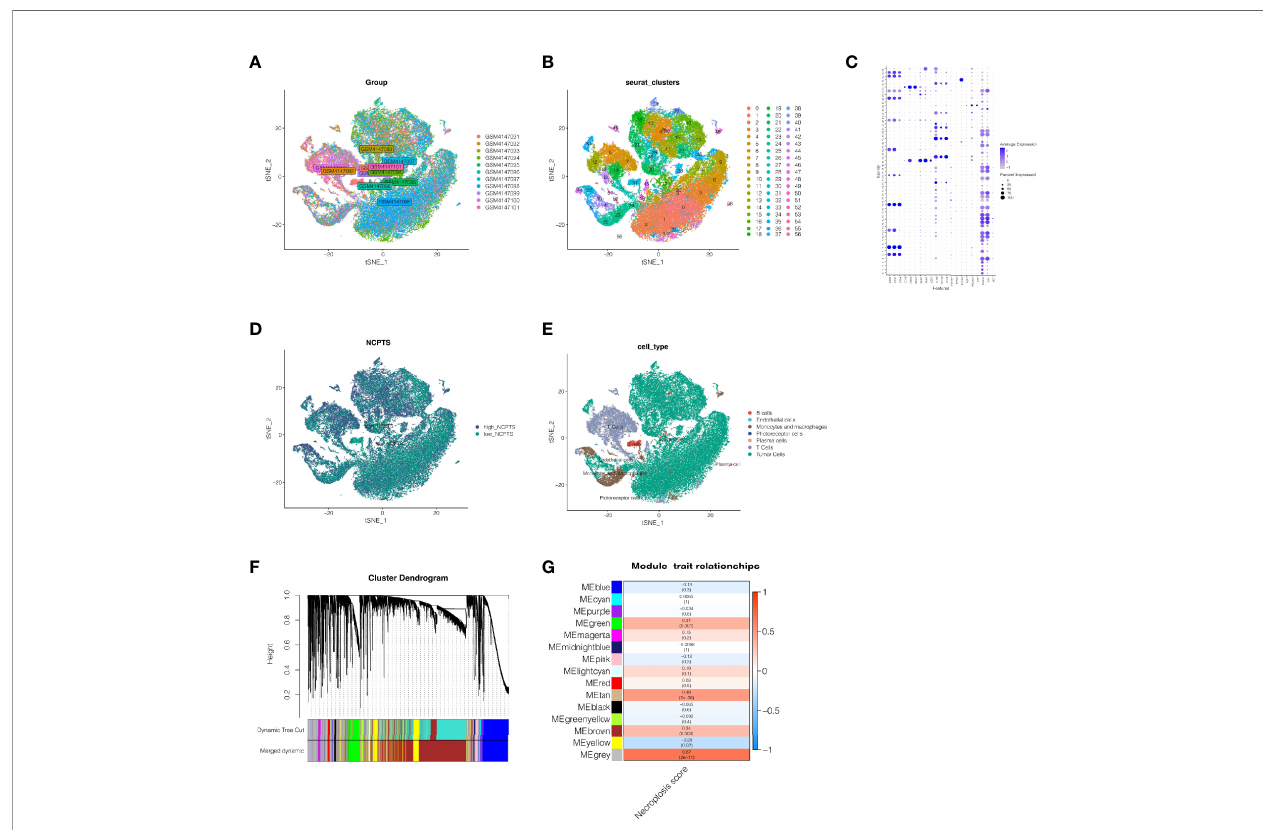
FIGURE 2 | Single cell sequencing analysis of GSE139829. (A) The integration effect of 11 samples is good. (B, C) Dimensionality reduction and cluster analysis. All cells in 11 samples were clustered into 57 clusters. (D) The percentage of necroptosis genes in each cell. The cells were divided into high- and low-necroptosis cells. (E) According to the surface marker genes of different cell types, the cells are annotated as B cells, endothelial cells, monocyte and macrophages, photoreceptor cells, plasma cells, T cells and Tumor cells, respectively. (F, G) WGCNA found that MEgreen, MEtan, and MEbrown modules were closely related to the score of